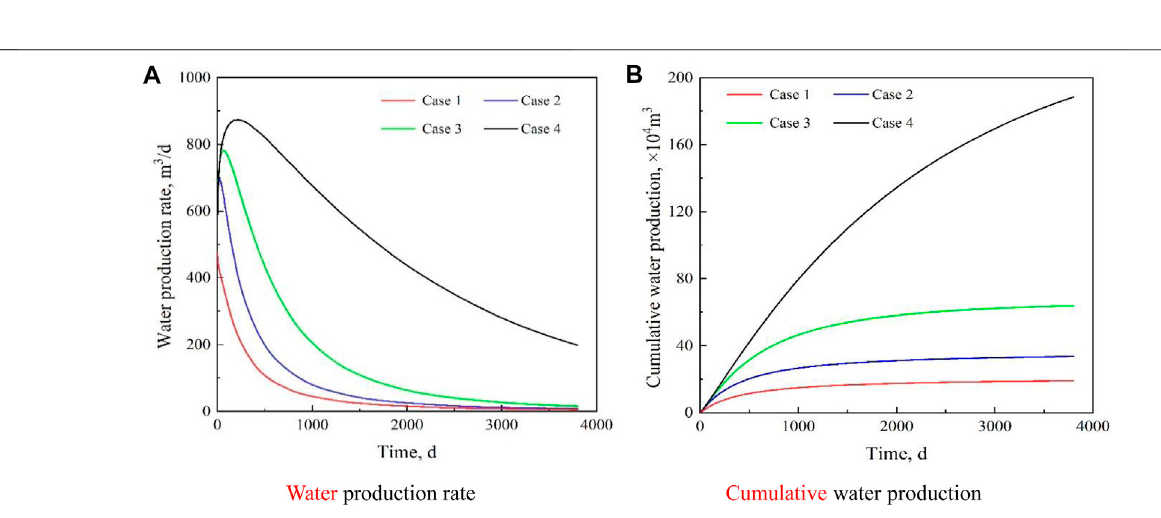
FIGURE 6 | In fl uence of aquifer on water production. (A) Water production rate. (B) Cumulative water production.